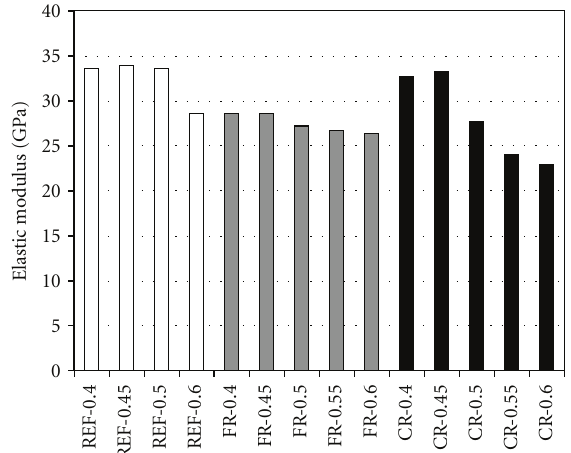
Figure 2: Static elastic modulus after 28 days of wet curing.